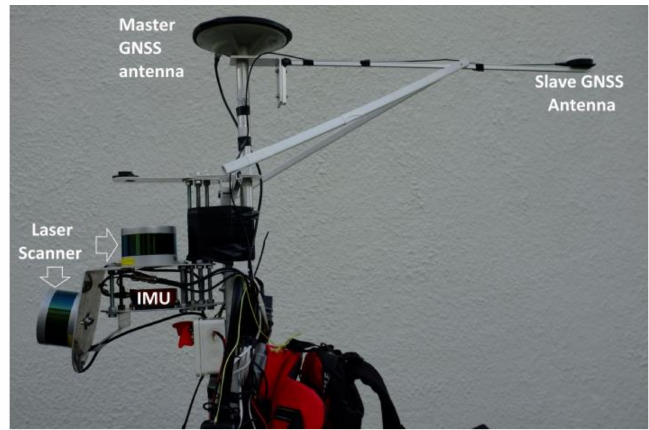
Figure 1. In-house-built backpack laser